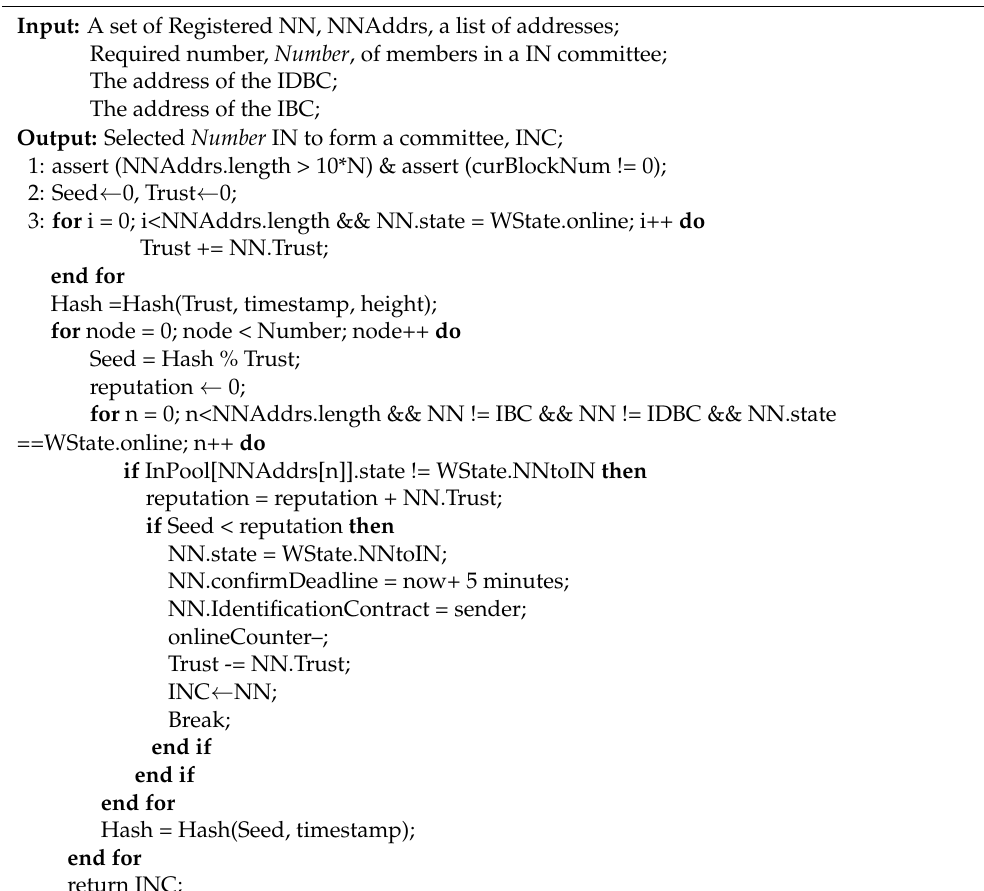
Algorithm 1 Reputation-Based Random Selection